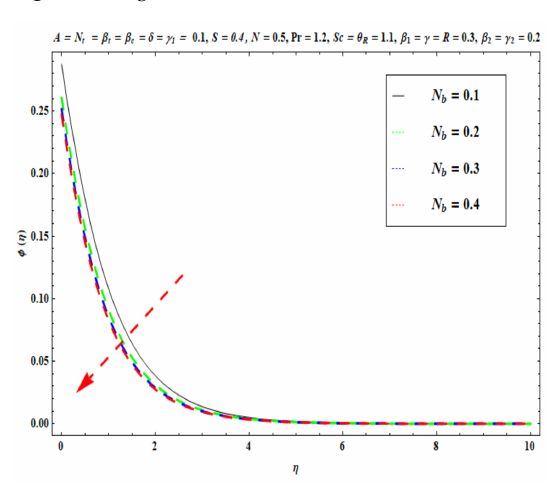
Figure 17. Against N b .